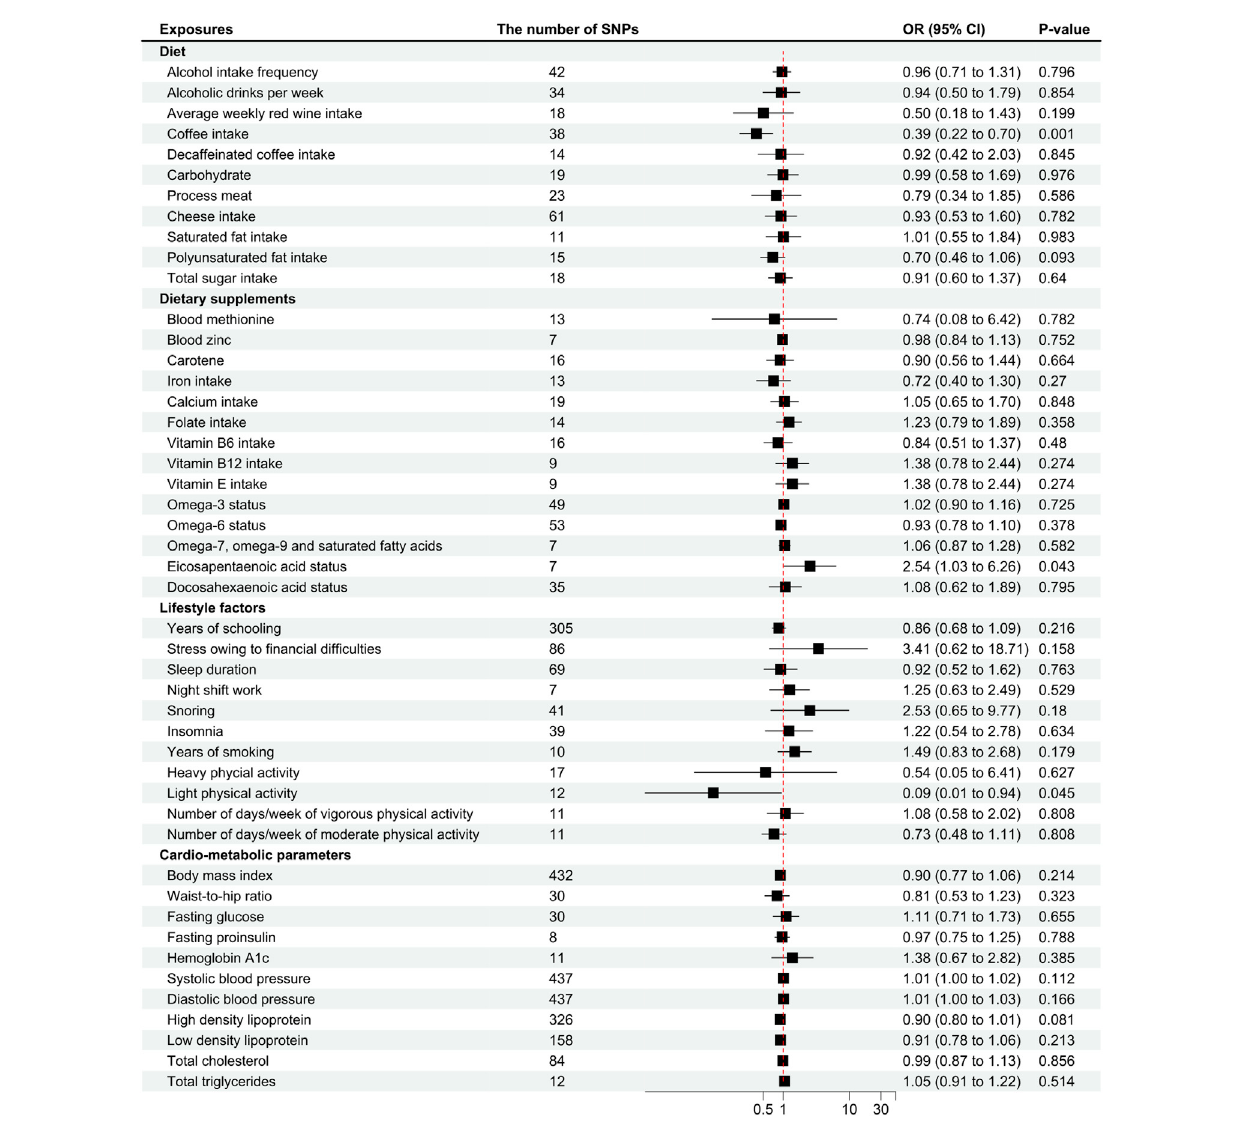
FIGURE 3 Odds ratios for associations between genetically predicted risk factors and migraine with aura. OR, odds ratio; SNP, single nucleotide polymorphisms. Annotation: We used the inverse-variance weighted method to calculate the odds ratios for individual SNPs. The odds ratio represents the odds ratio per genetically predicted SD unit increase in the risk